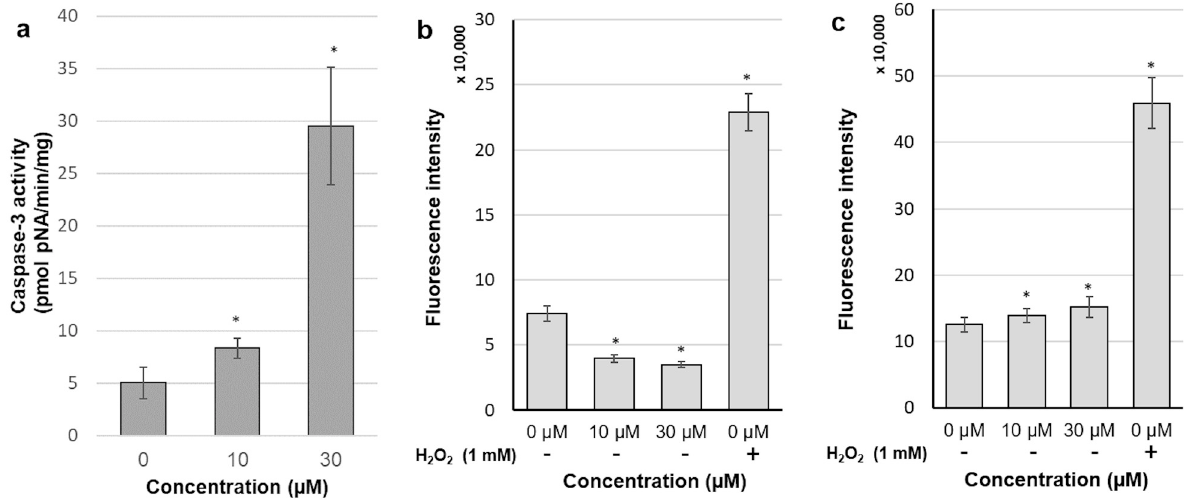
Figure 7. Effect of 6 h exposure to compound 4 on caspase-3 activity in the SK-BR-3 cell line ( a ); effect of compound 4 on ROS generation in SK-BR-3 cells ( b ); effect of compound 4 on ROS generation in the MCF-7 cell line ( c ); each bar represents the mean ± SD; * p < 0.05 compared with control.